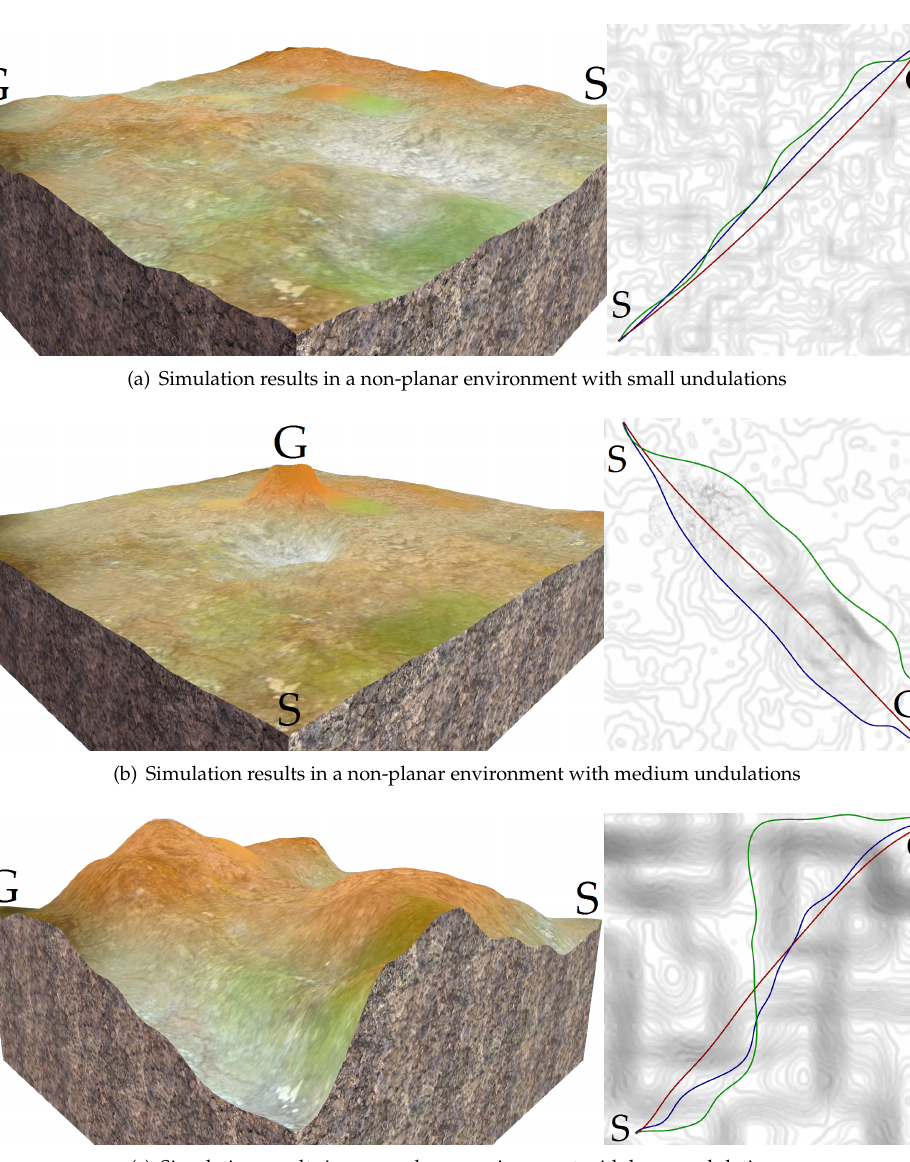
Figure 15. The trajectories generated by NoTS (red), TS-NoSus (green), and TS-Sus